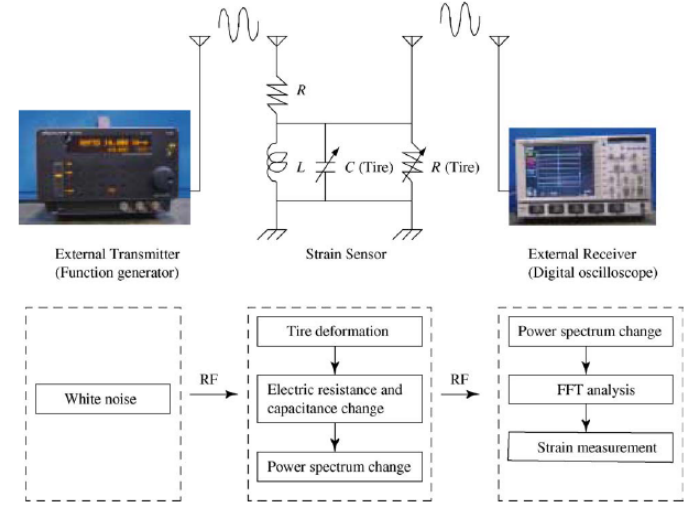
Figure 6. Schematic image of the wireless passive strain measurement system using a tuning circuit and frequency filtering. The diagram is from Matsuzaki et al . [79] and is reprinted with permission from